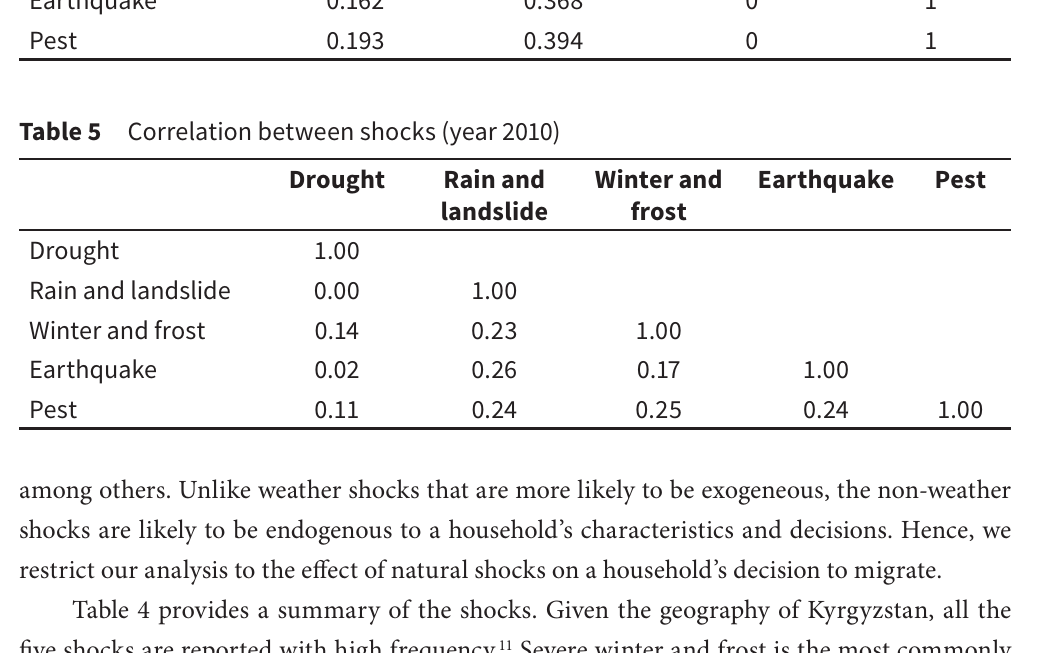
Correlation between shocks (year 2010)